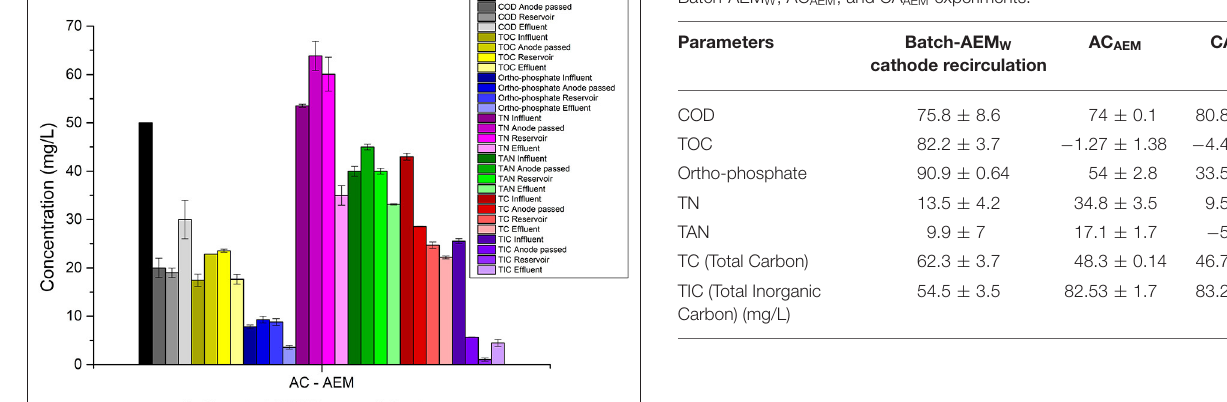
TABLE 4 | Percentage reduction in wastewater parameters achieved in Batch-AEM W , AC AEM , and CA AEM